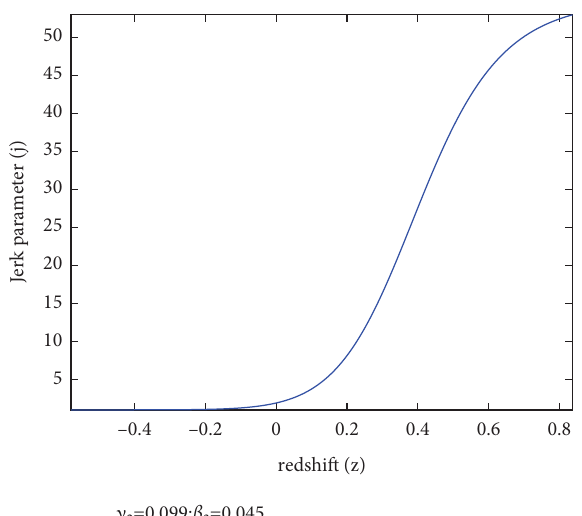
Figure 12: Jerk ( j ) versus redshift ( z ) for